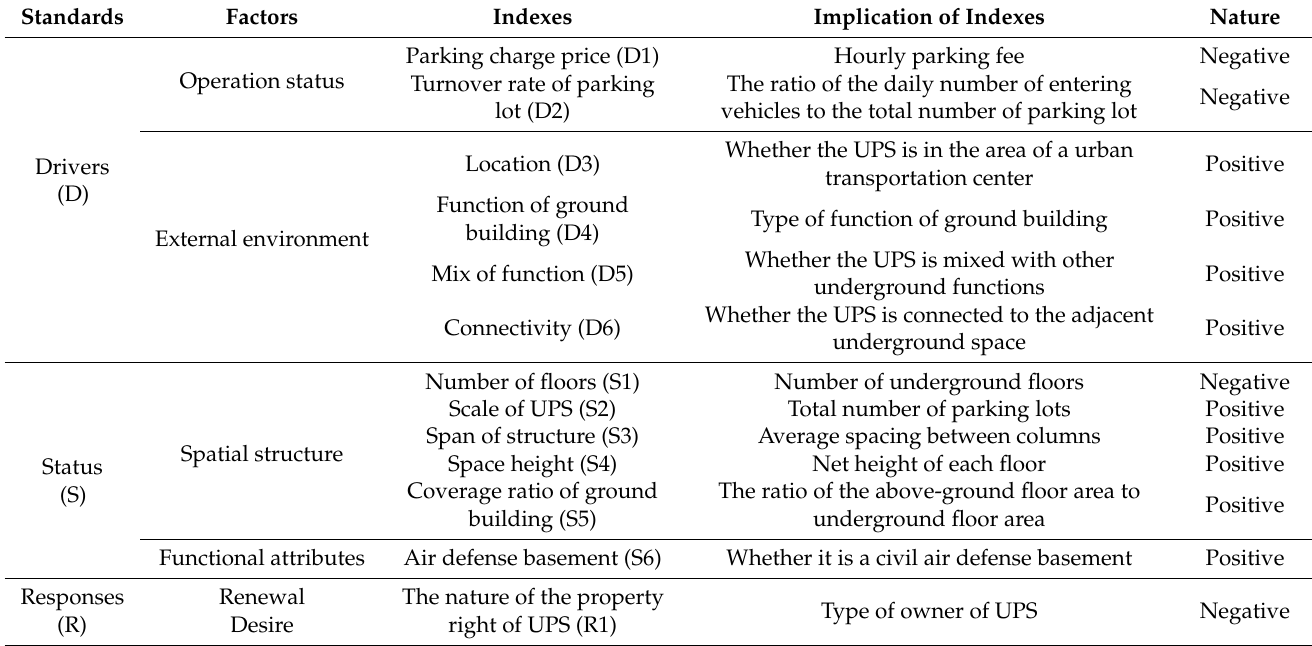
Table 1. Indexes system of DSR Model.